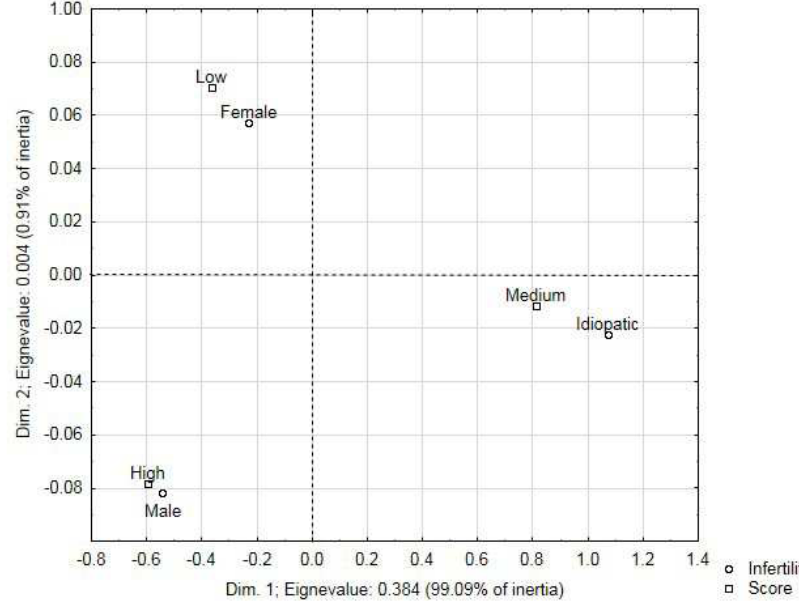
Figure 2. Correspondence map: cause of infertility vs. the number of know- ledge assessment points